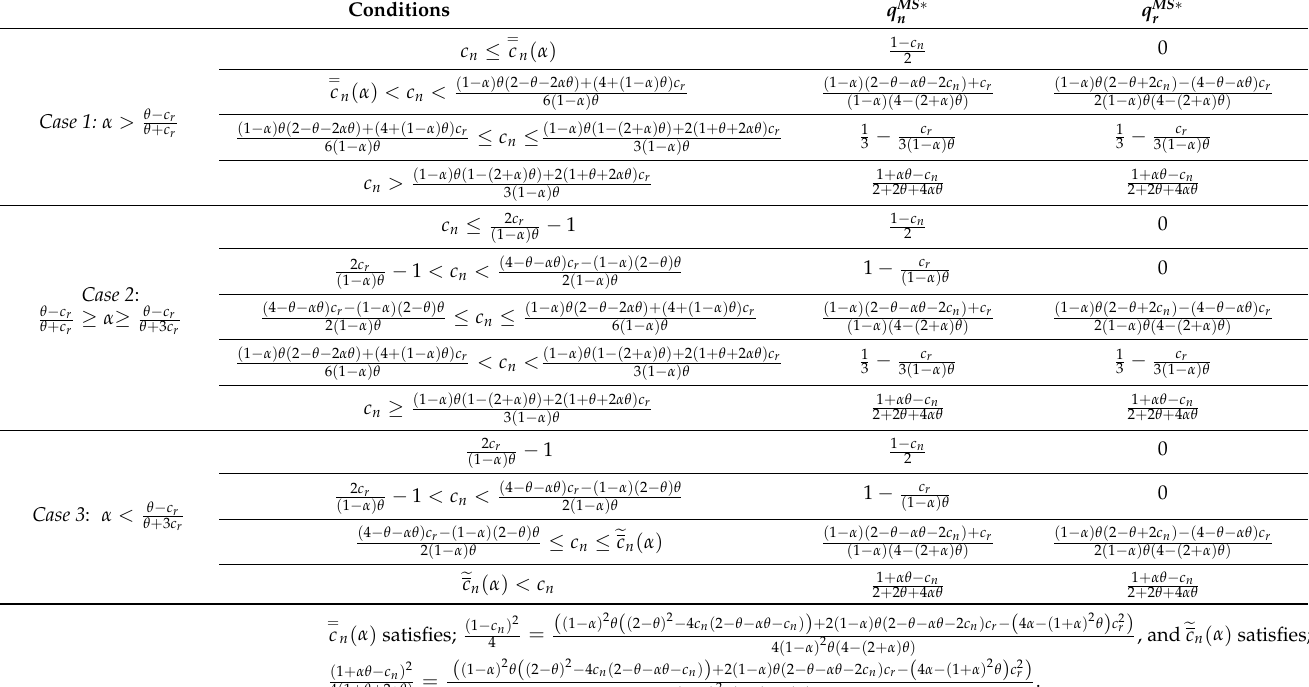
Table 1. Optimal decisions of platform firm and IR under marketplace model with Stackelberg